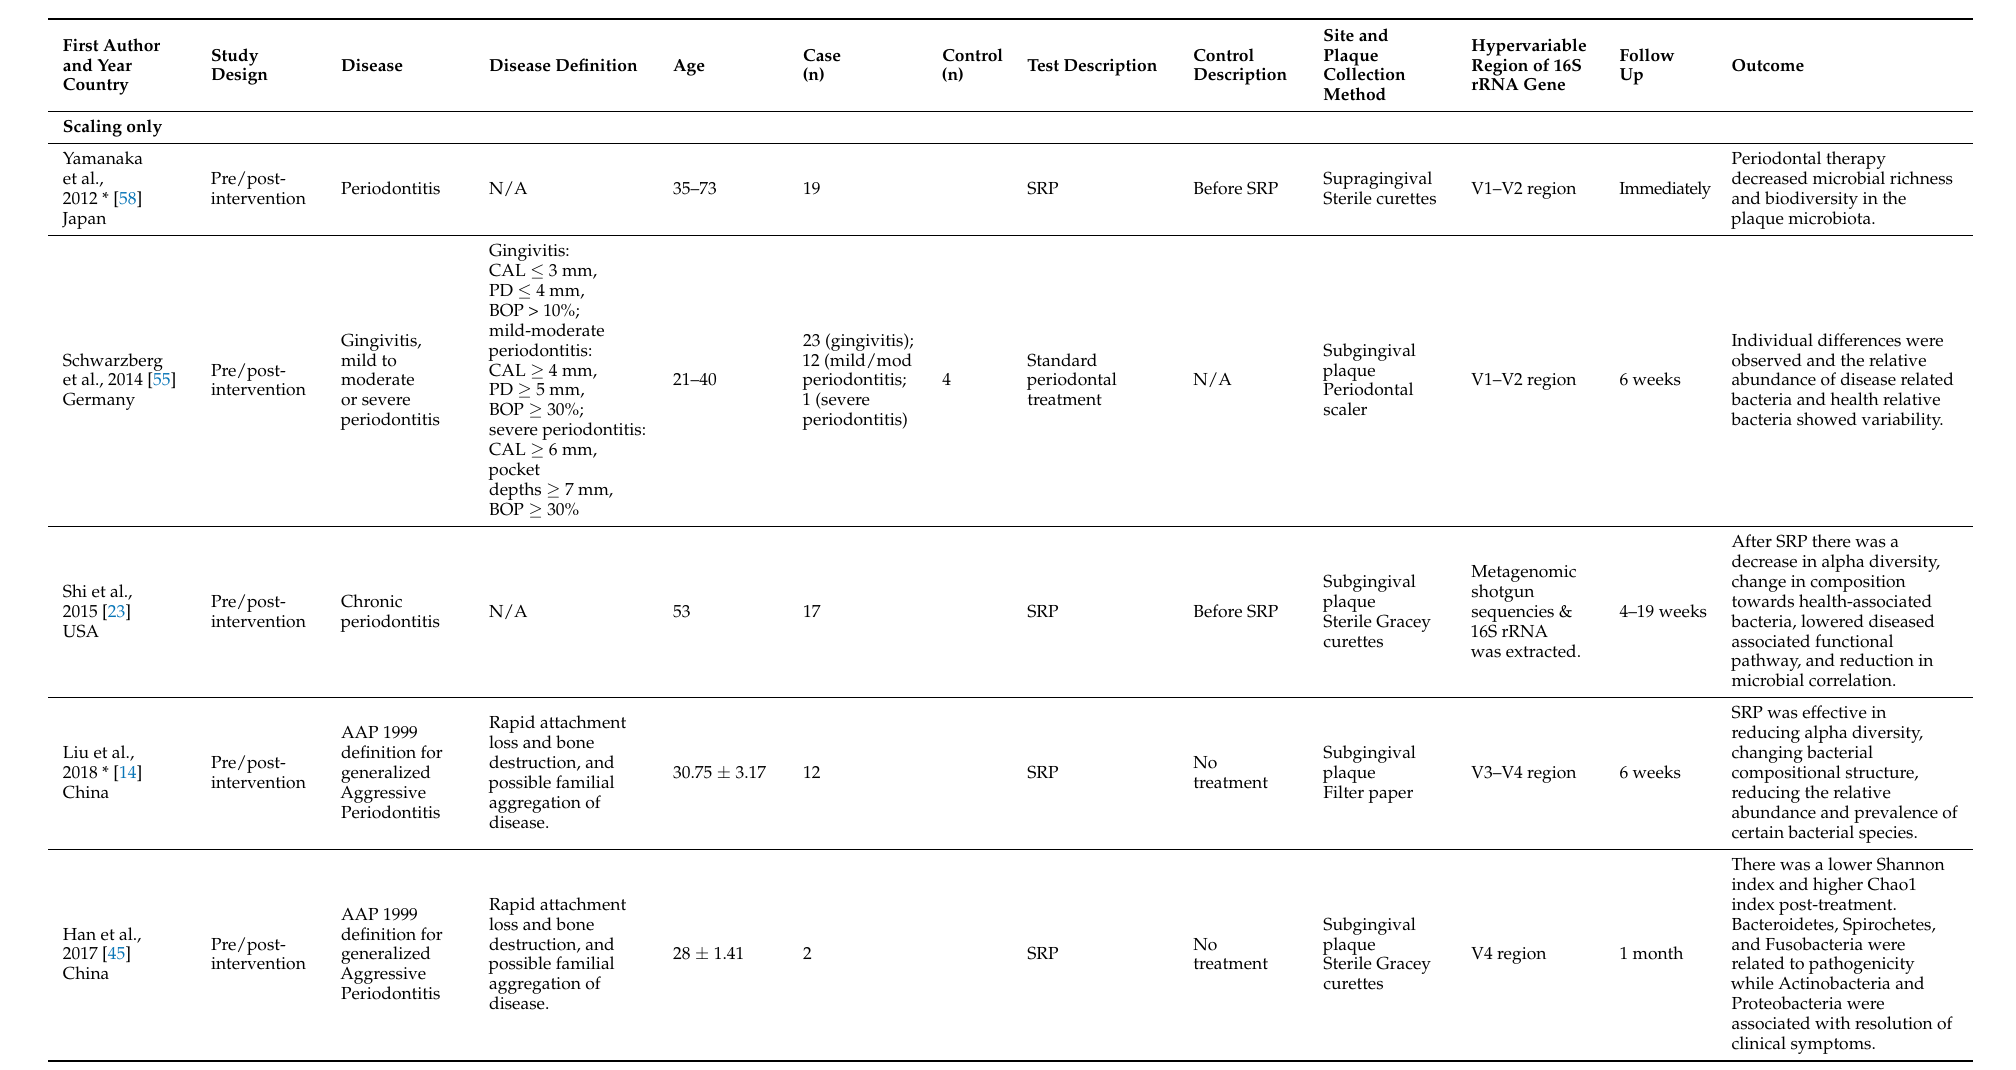
Table 1. Characteristics of included studies according to treatment